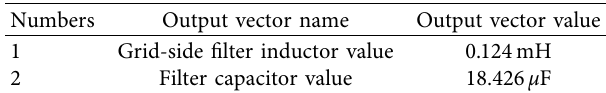
Table 3: Improved PSO-LSSVM model output vector.